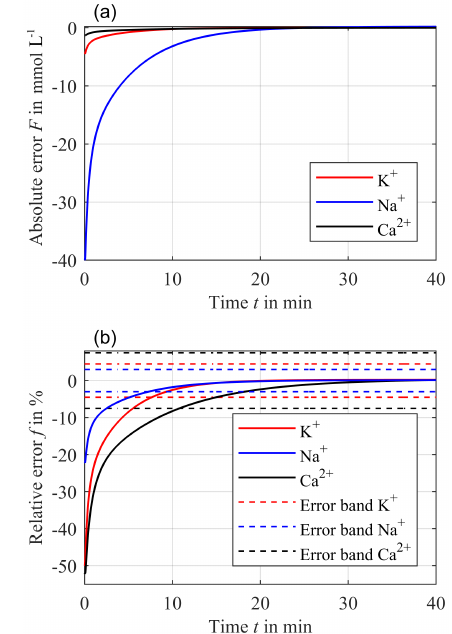
Figure 7. Resulting absolute error F between c comp and ex- ponentially decreasing c blood − sim with 10%h − 1 for a dis- tance h s = 0.9mm (a) and the corresponding relative error f (solid line) (b) for potassium (red line), sodium (blue line) and calcium (black line). The dashed lines in (b) are the required accuracy of ± 3% for sodium, ± 4.5% for potassium and ± 7.5% for calcium.